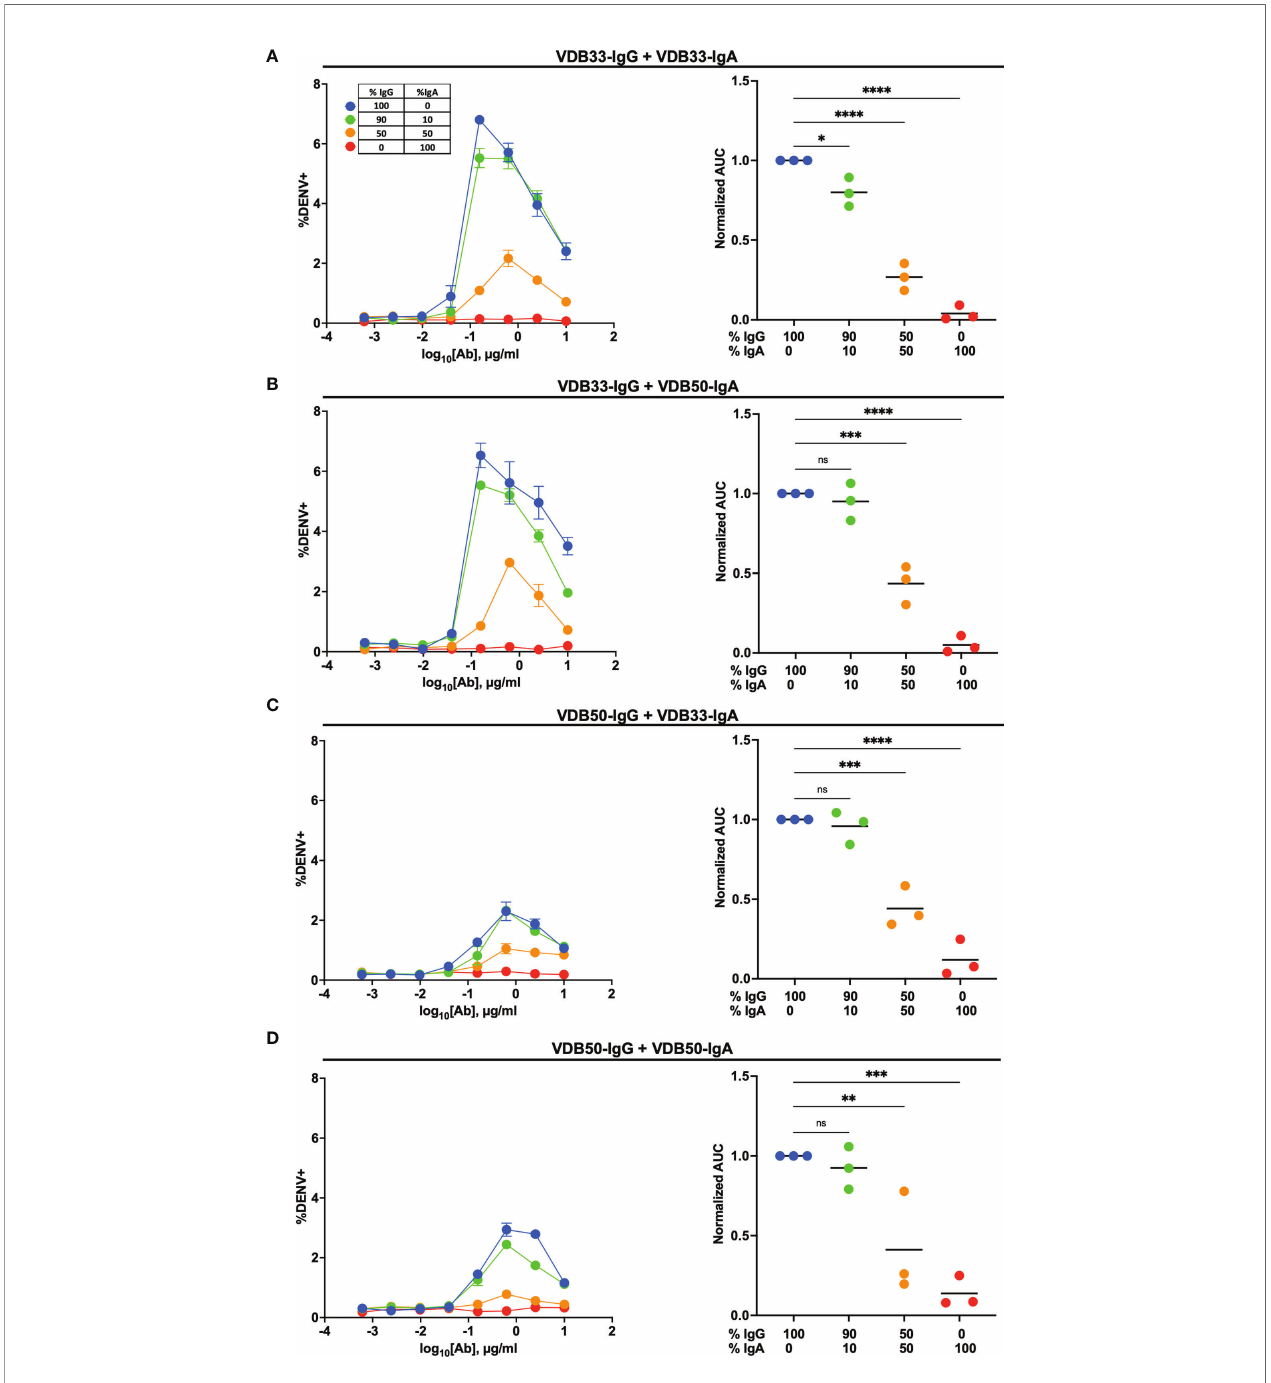
FIGURE 3 | Homotypic and heterotypic monoclonal IgA antagonizes IgG-mediated antibody-dependent enhancement. (A) DENV-3 ADE activity of VDB33-IgG when antagonized with VDB33-IgA. Total antibody concentration for each dilution point was held constant, with varying ratios of VDB33-IgG and VDB33-IgA as indicated. AUC of each ADE titration was calculated and normalized to that of the 100% IgG condition. (B) DENV-3 ADE activity of VDB33-IgG when antagonized with VDB50-IgA. The AUC of each ADE titration was calculated and normalized to that of the 100% VDB33-IgG condition. (C) DENV-3 ADE activity of VDB50-IgG when antagonized with VDB33-IgA. AUC of each ADE titration was calculated and normalized to that of the 100% VDB50-IgG condition. (D) DENV-3 ADE activity of VDB50-IgG when antagonized with VDB5o-IgA. AUC of each ADE titration was calculated and normalized to that of the 100% VDB33-IgG condition. Blue = 100% IgG/0% IgA. Green = 90% IgG/10% IgA. Orange = 50% IgG/50% IgA. Red = 0% IgG/100% IgA. "ns" denotes "non-signi fi cant" (p > 0.05). *p < 0.05, **p < 0.01, ***p < 0.001, ****p < 0.0001 1-way ANOVA with Dunnett correction for multiple comparisons. Data are representative of at least 4 independent